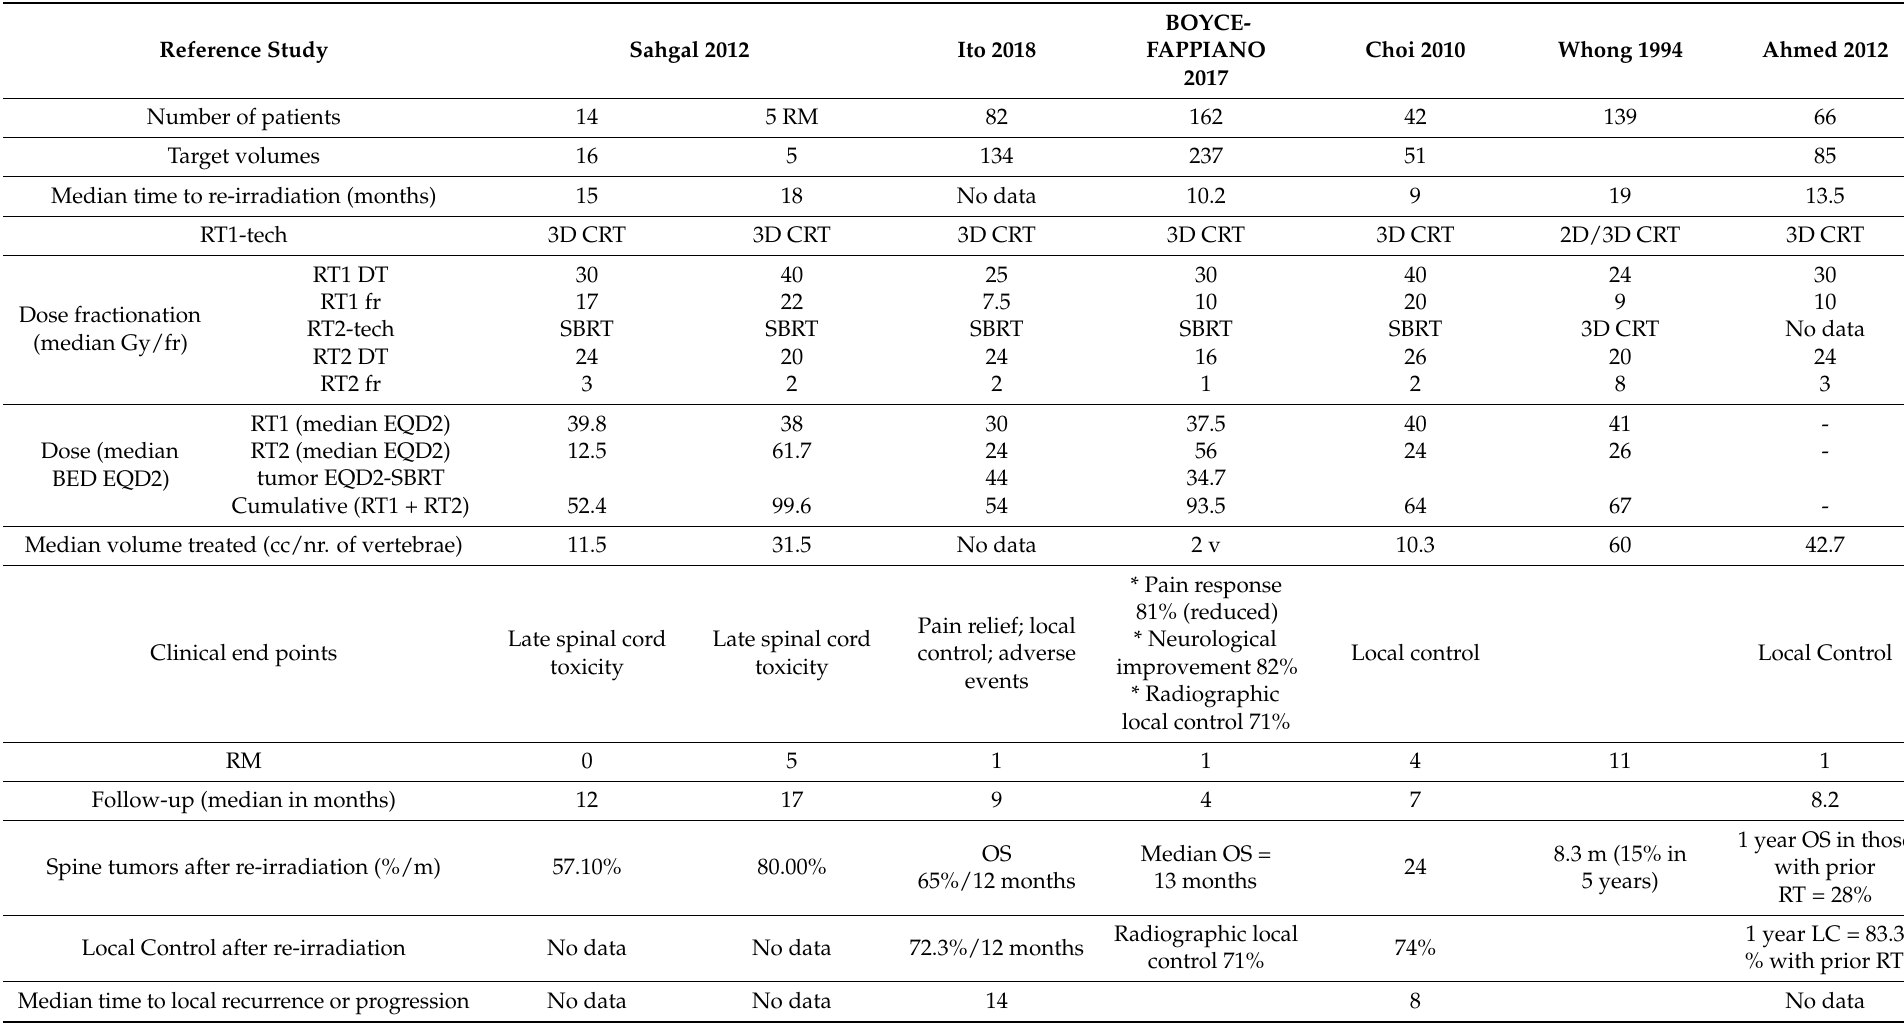
Table 2. Selected studies reporting radiation induced myelopathy (RM) with corresponding dose and